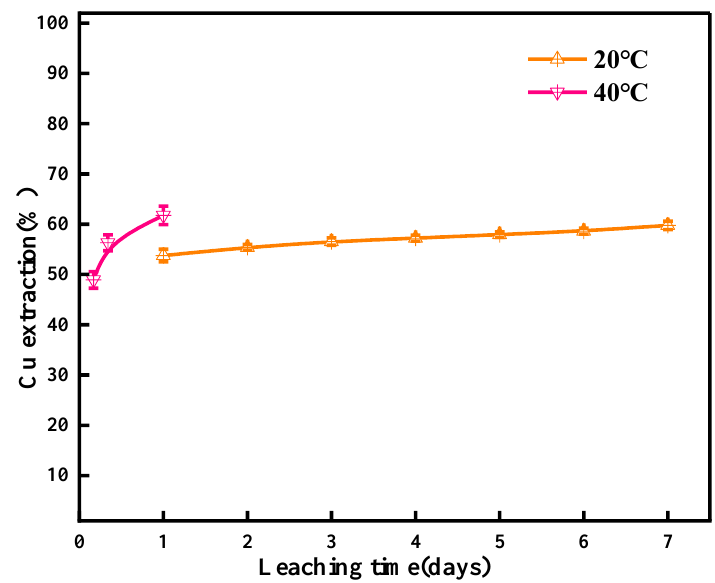
Figure 5. Effect of temperature on metal extractions of COBL ore in agitation leaching.